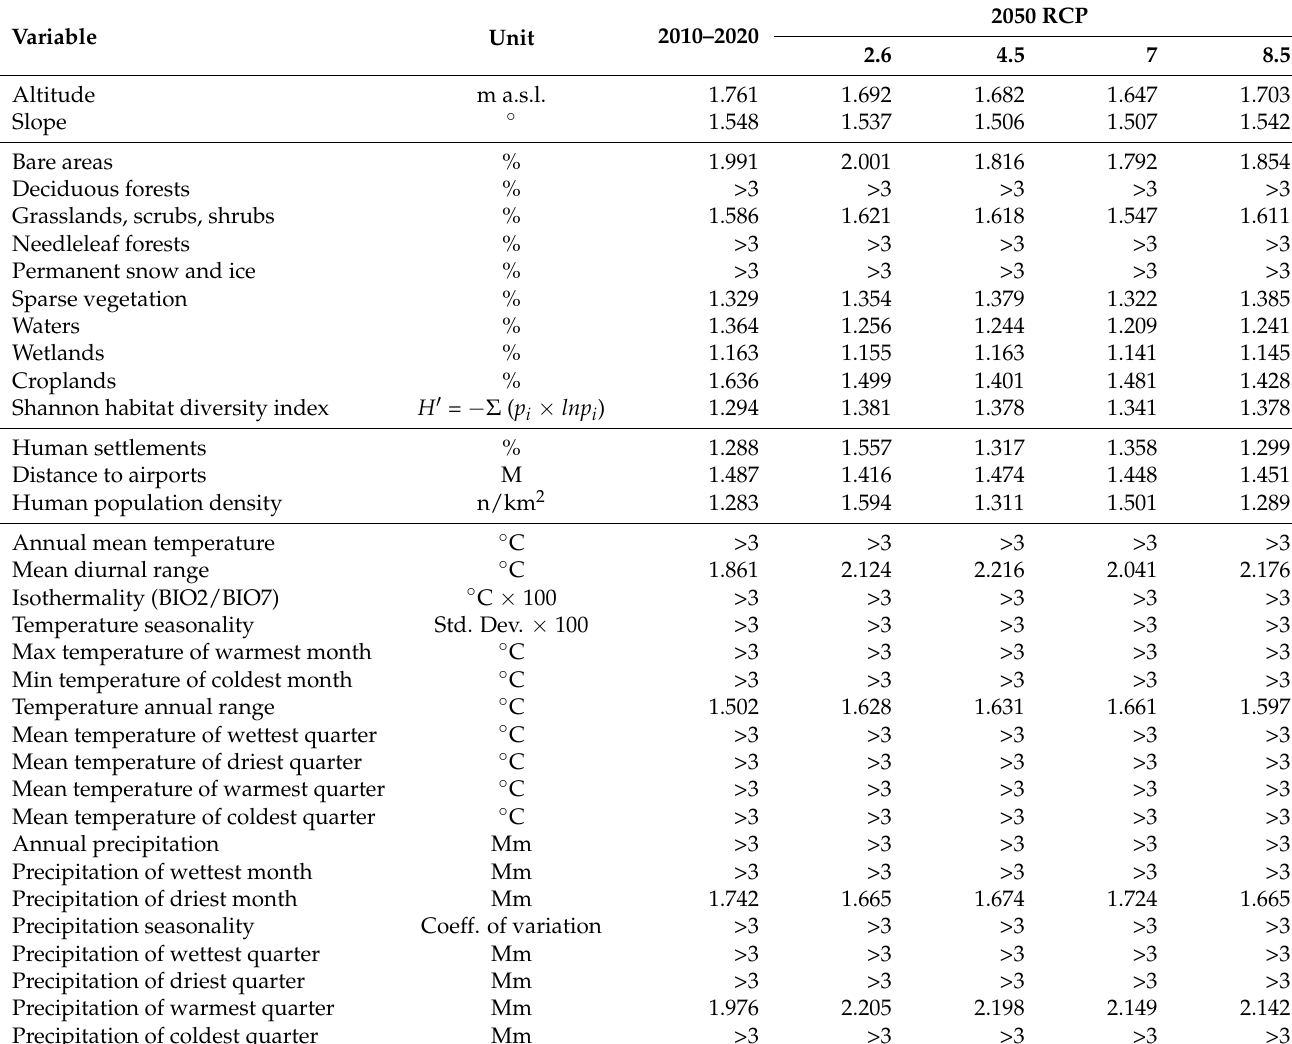
Table 1. Predictor variables considered and their relative variance inflation factor (VIF). Predictors with VIF > 3 were not considered in further